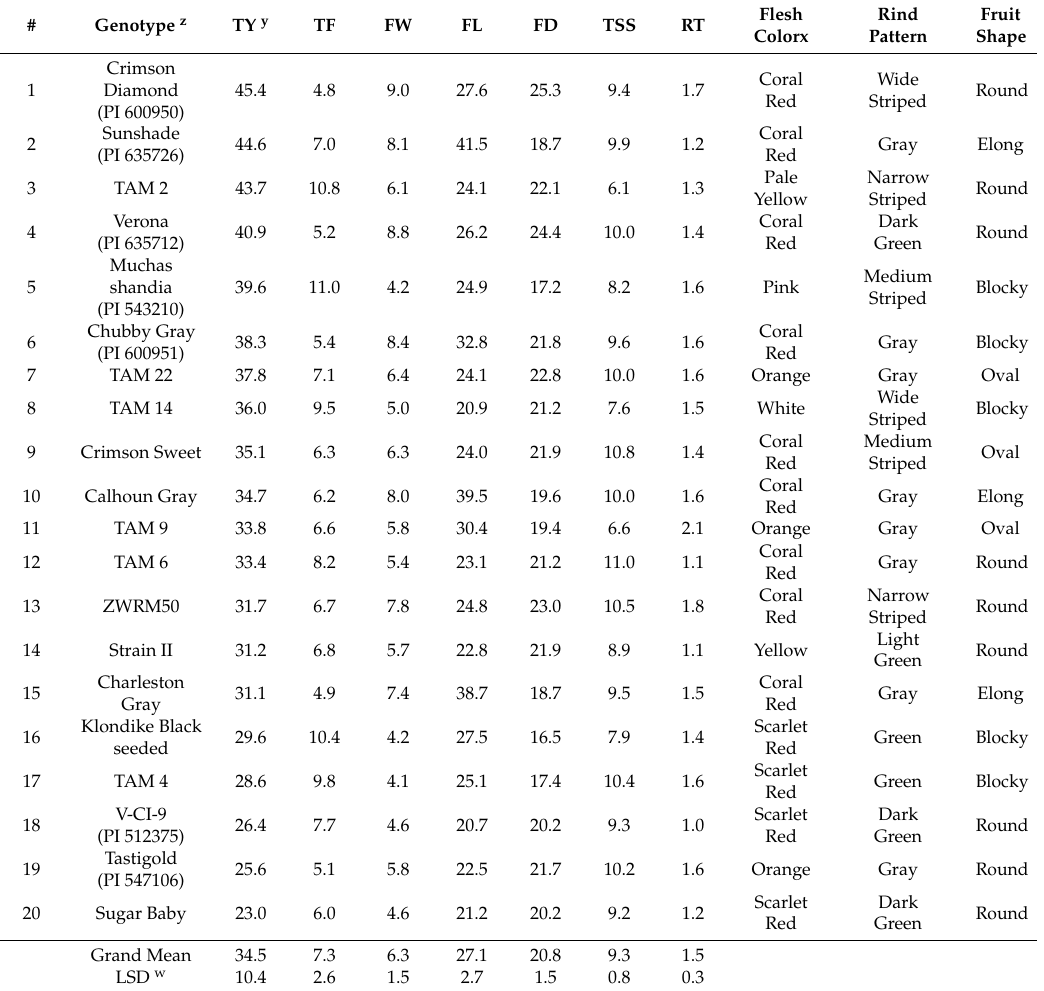
Table 2. Mean for yield parameters and fruit appearance characteristics on twenty genotypes evaluated at Uvalde and Weslaco TX in 2018 and